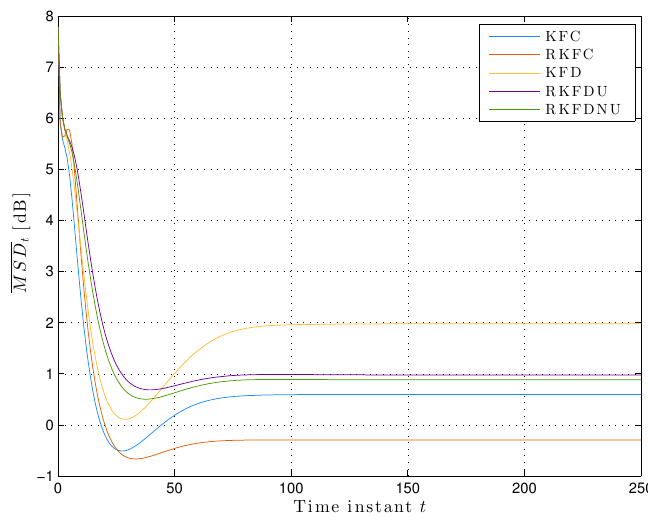
Figure 5. Least favorable mean square deviation across the network with tolerance c = 0.06.